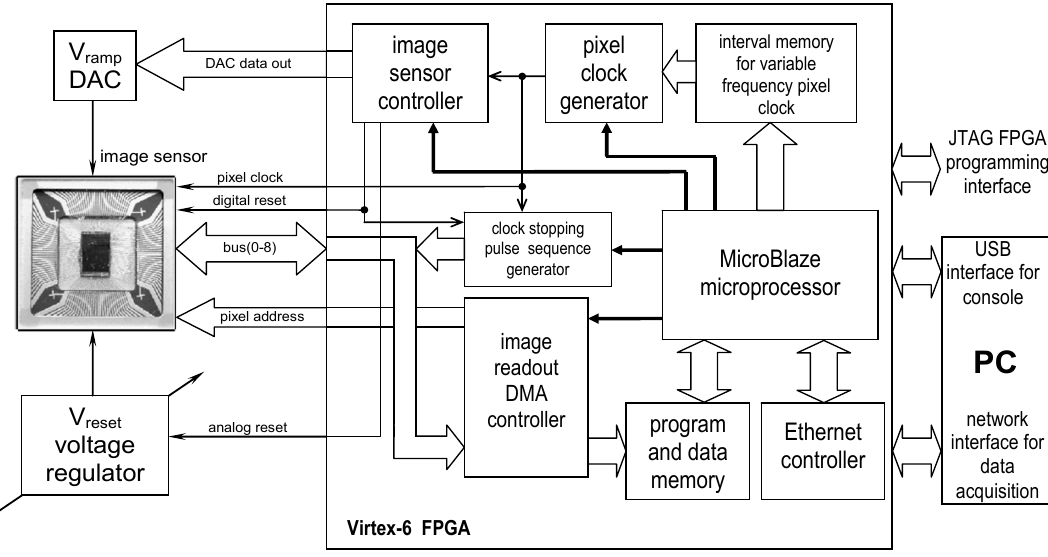
Figure 5. Block diagram of the imager measurement system.